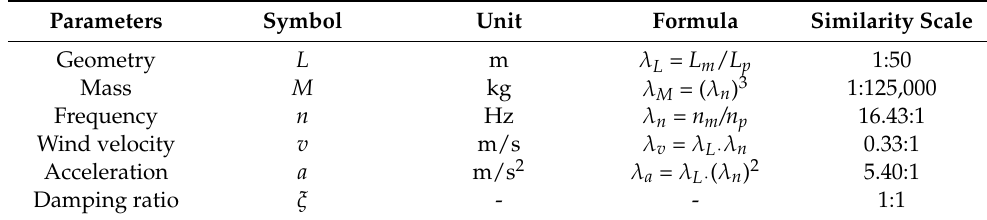
Table 1. Similarity ratios of the scaled LT